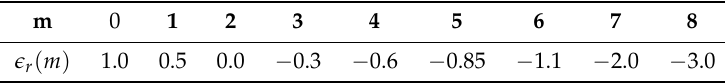
Table A1. Offset energies (cid:101) r ( m ) to different methylation levels m